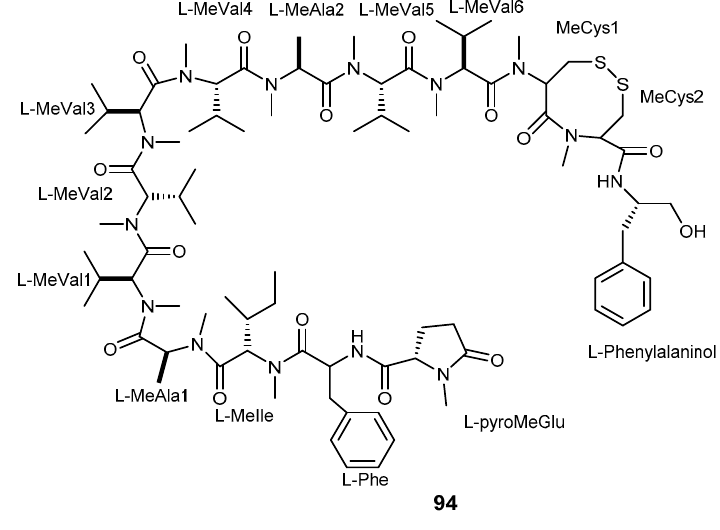
Figure 19. Structure of kendarimide A ( 94 ).